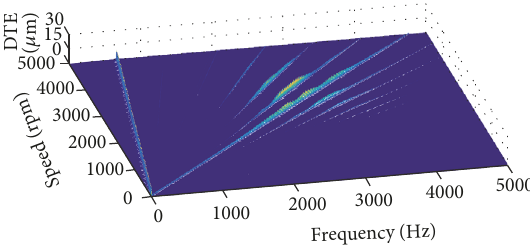
Figure 16: Waterfall diagram of the DTE of the system obtained using STE curves reported in Figure